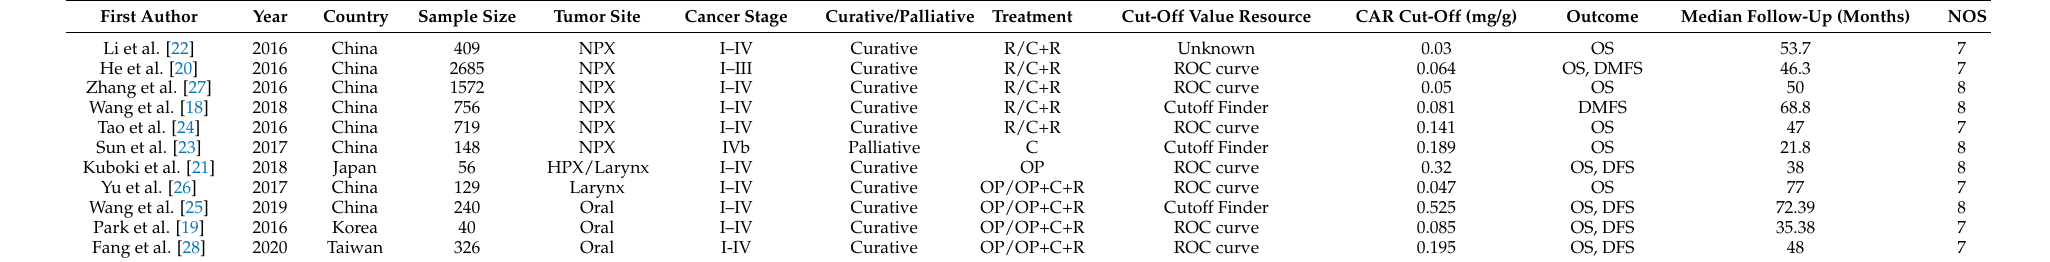
Table 1. Demographic characteristics of patients in the included